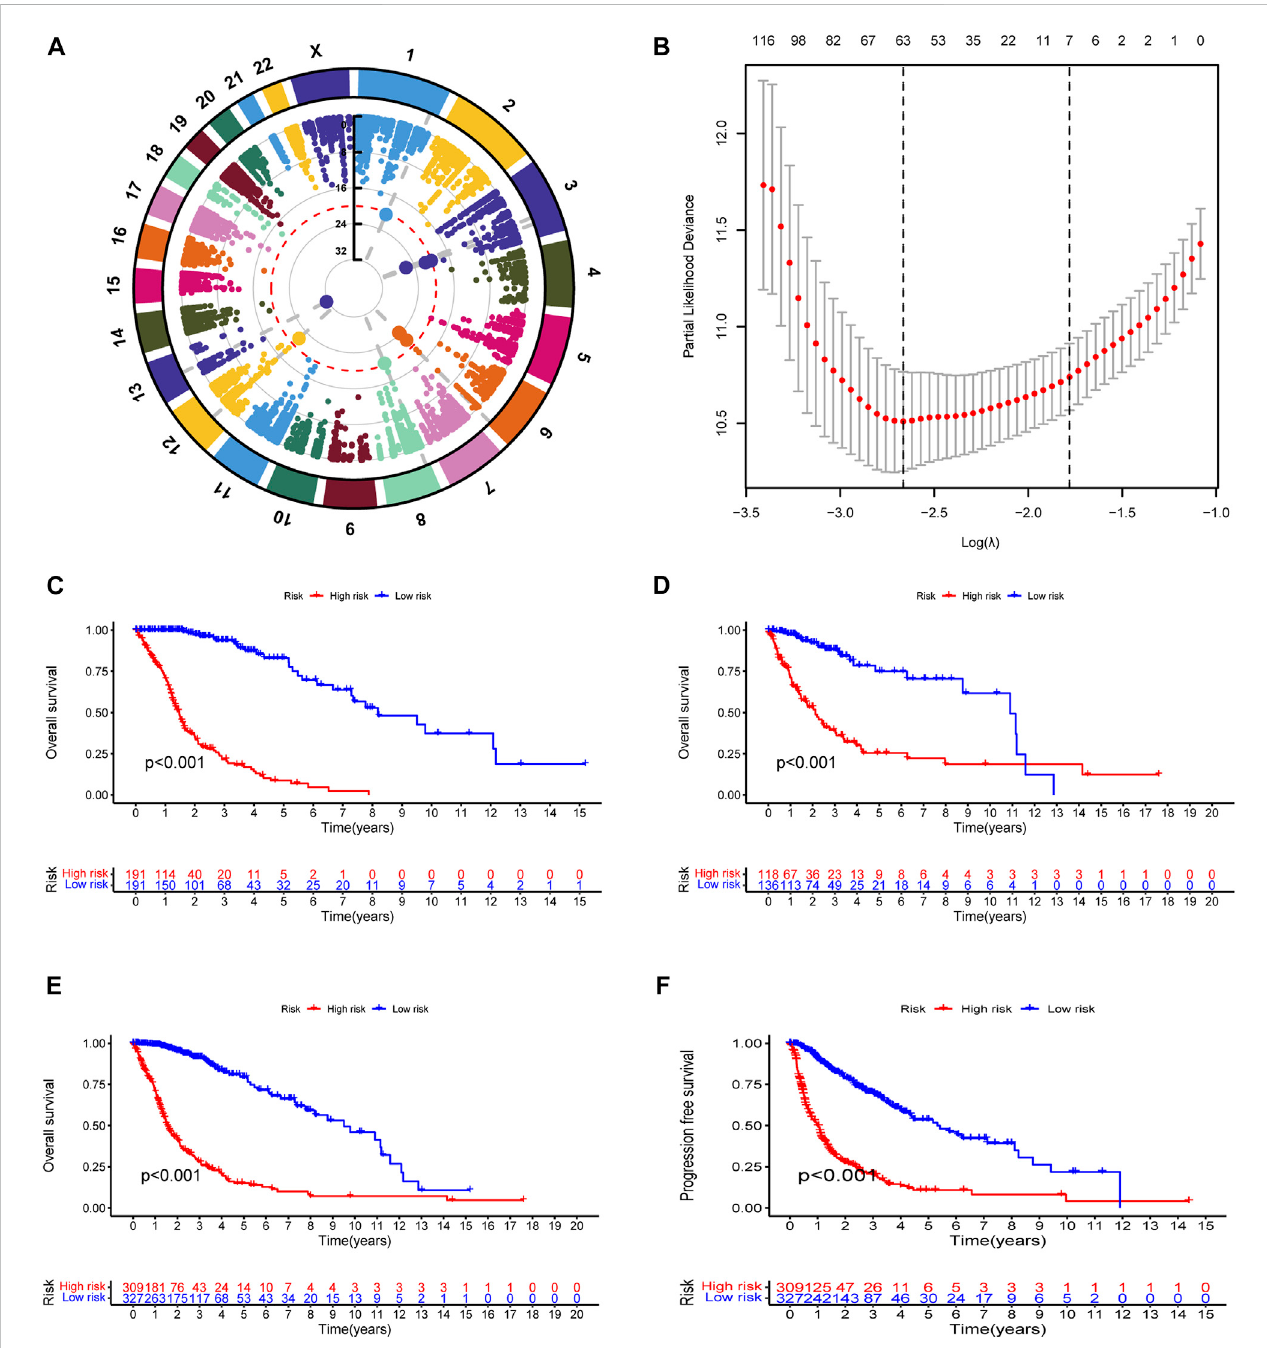
FIGURE 1 Constructionand evaluation ofprognostic RNA-editing signature inglioma: (A) Manhattan plotshowingthe global landscapeof RNA-editing alterations with prognostic implications in gliomas. The number in the middle line indicates the − log10(p) for each RNA editing. The top signi fi cant RNA editings with − log10(p) > 20 were labeled in larger dot size. The grey dashed lines at from chromosomes to the middle demonstrated the chromosome location of those top signi fi cant RNA editings. (B) The cross-examination process to identify the optimal λ parameter. The x-axis showed thelog( λ )value, and y-axis showed the corresponding likelihood deviation value. The vertical dashed line on the left corresponds to the optimal λ value; and the vertical dashed line on therightindicatesthe λ valueofmodelwiththeevaluationindexwithin1standarderroroftheoptimal λ value,namelylambda.1se.Theuppernumbersarethe number of edits enrolled for construction of model for each λ . In our model, the optimal log( λ ) is around − 2.6, with the corresponding likelihood deviation around − 10.5 and 63 RNA editings were enrolled for prognostic examination. (C – F) Kaplan-Meier (K-M) survival analysis was performed to examine the prognostic value of the risk signature. Total risk score of each sample was calculated with editing levels of those thirty- fi ve PREs and corresponding multivariate cox regression coef fi cients. Glioma samples were then divided into high- or low-risk groups based on risk score (median as the cutoff value). High-risk groups showed poorer survival in all of the training cohort (C) , testing cohort (D) , and overall glioma patients (E) , and shorter PFI in overall glioma patients (F)